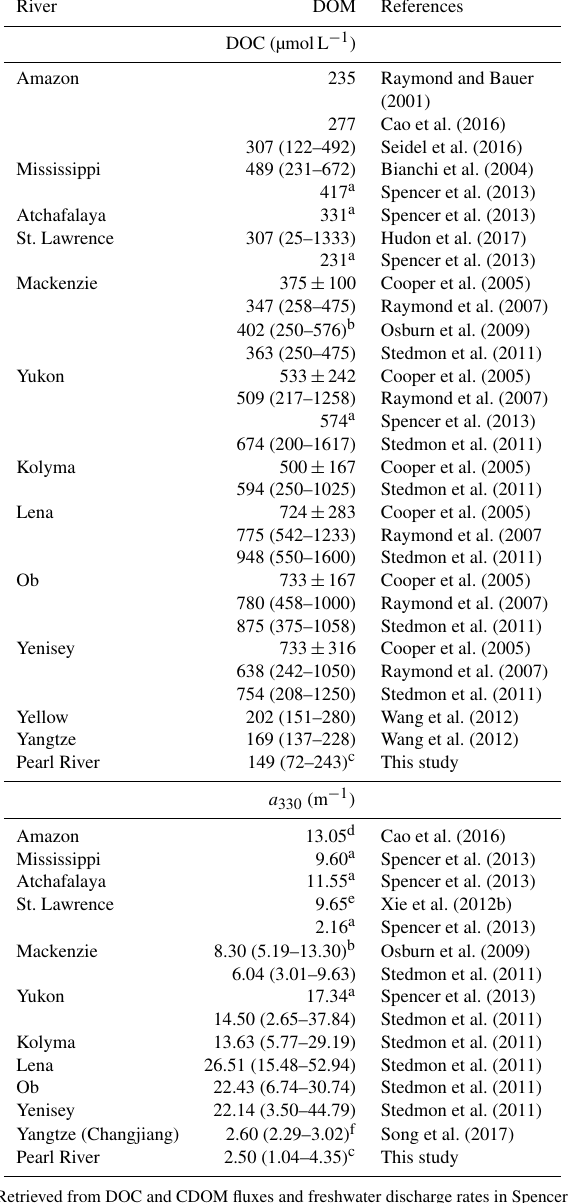
Table 4. CDOM fluxes ( a 330 -based) from major world rivers to the ocean reported in the literature. The flux estimated for the Pearl River by this study is also included for